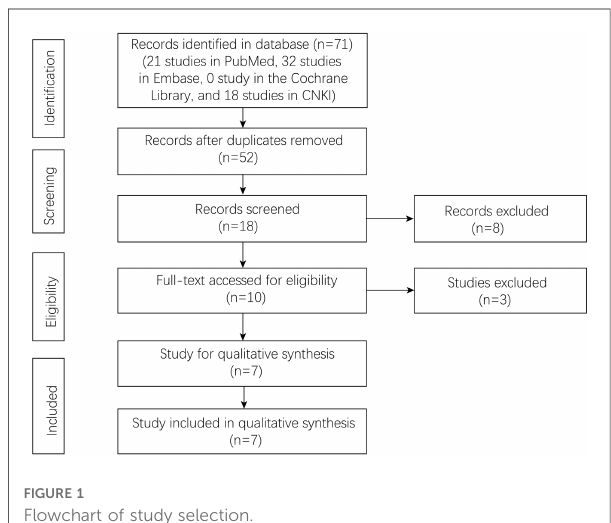
FIGURE 1 Flowchart of study selection.